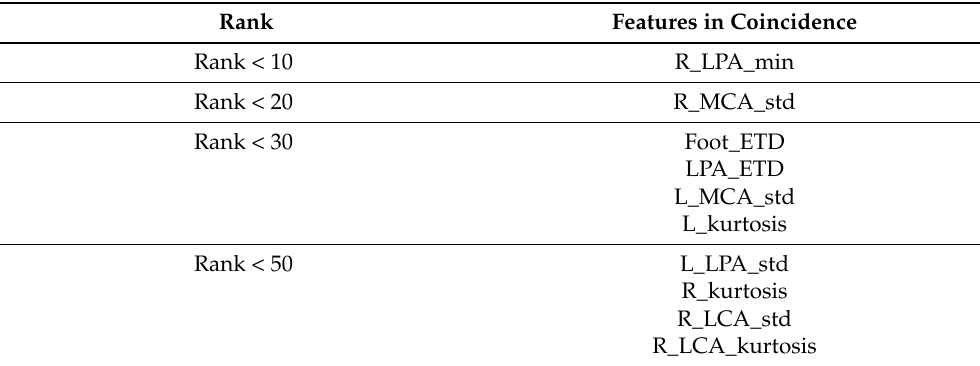
Table 4. Most relevant features that coincided in all the approaches considered, listed according to rank. Rank Features in Coincidence